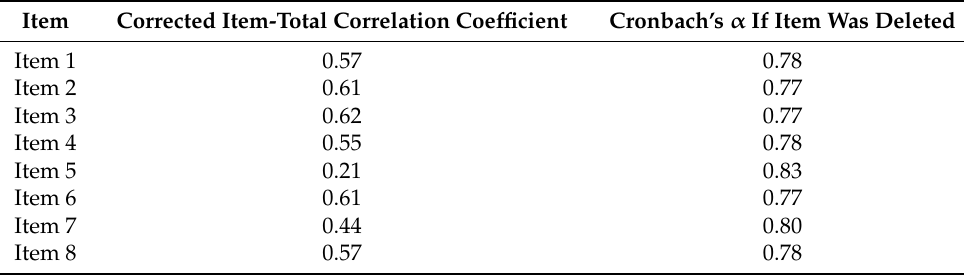
Table 1. Reliability measurement of the C-MMAS-8.